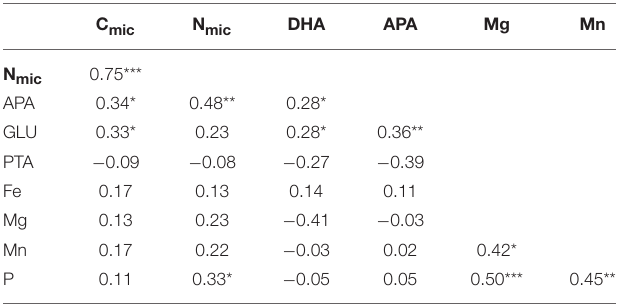
TABLE 5 | Pearson correlation coefficient among biochemical activities and plant available nutrients in surface of a rewetted peatland.